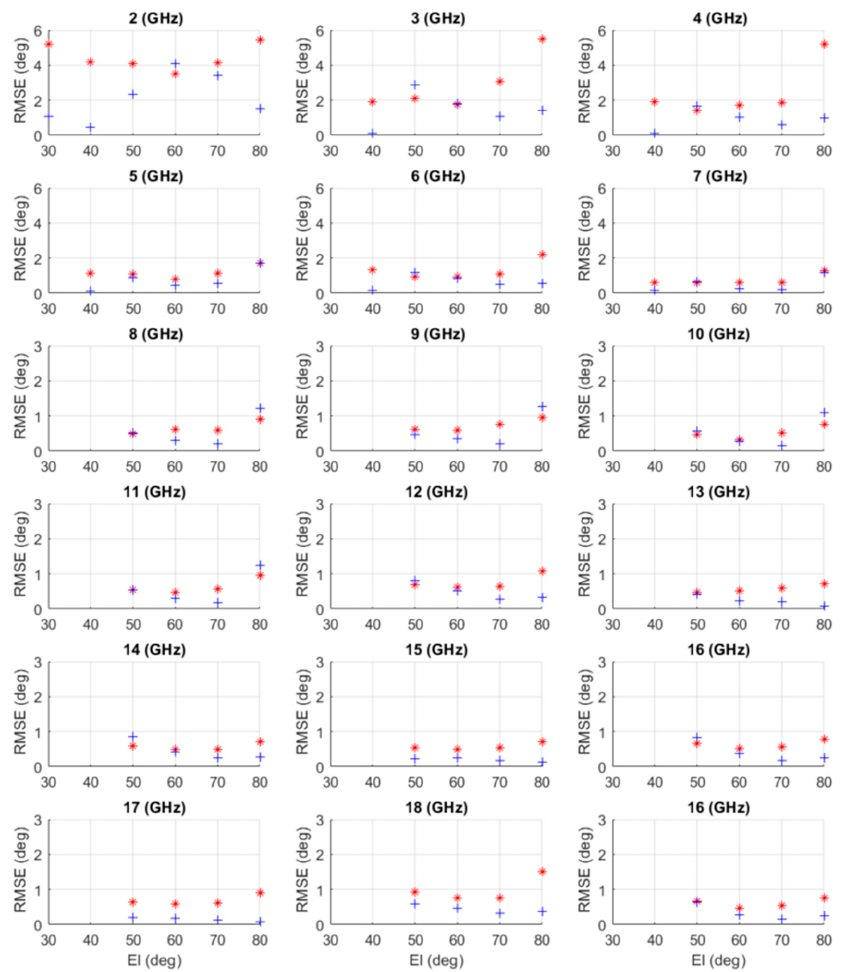
Figure 12. The RMSE of the measured AoA at a different frequency. Red*: RMSE of Az, and blue+: RMSE of El using 13 data points at each El-angle. From Figure 12, one can find that: